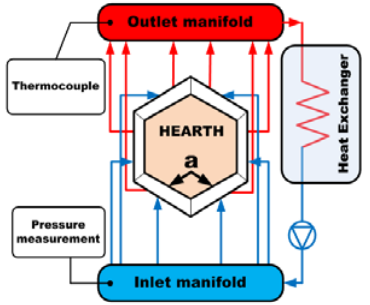
Figure 3. Scheme of the port cooling system.